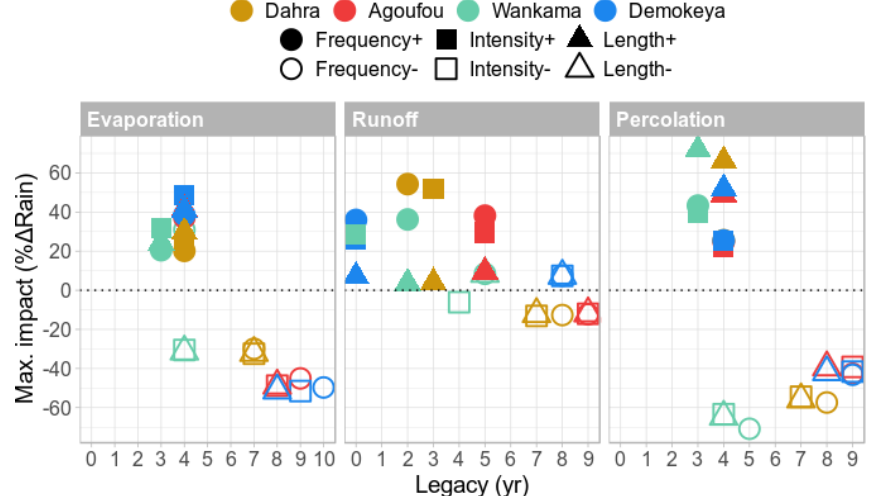
Figure 12. Impact of the different disturbance scenarios on surface water balance for all sites, showing the maximum impact on the surface evaporation, runoff and percolation as a percentage of added/reduced rainfall amount (% (cid:49) Rain), along with its legacy